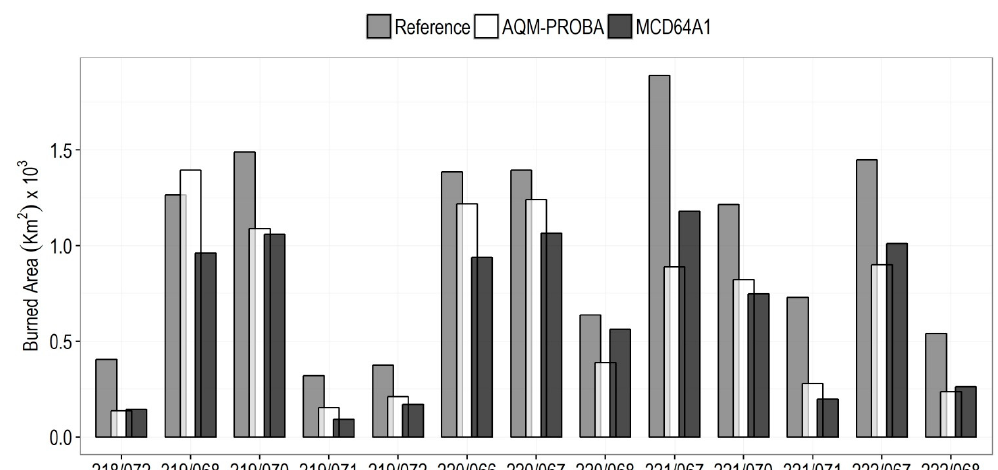
Figure 5. Total burned area for the 13 Landsat scenes, as obtained from the reference data (gray bars), Área Queimada —Project for On-Board Autonomy-Vegetation burned area product (AQM-PROBA) (white bars) and Moderate Resolution Imaging Spectroradiometer direct broadcast (DB) burned area product (MCD64A1) (black bars).